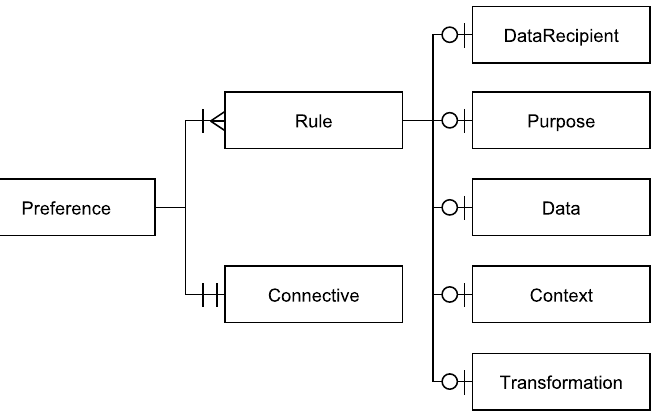
Figure 2. Hierarchical structure of the elements of a ConTra preference. Attributes are omitted from this